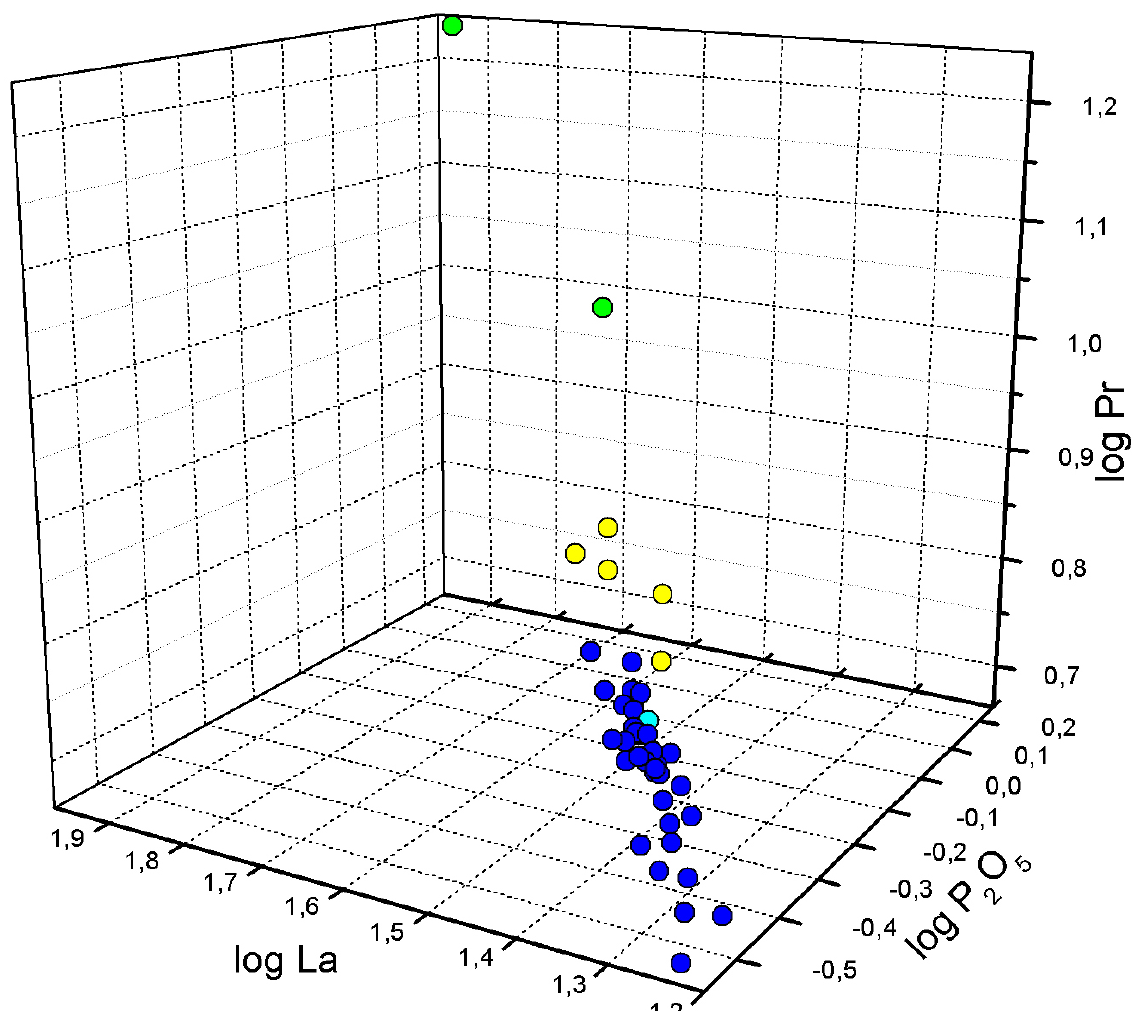
Figure 8. Combination of PCA and CA results: The log-transformed values of La, P2O5 and Pr. Spot colours as in Figure